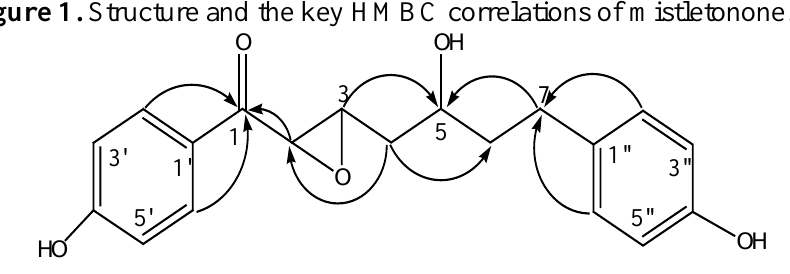
Figure 1. Structure and the key HMBC correlations of mistletonone.